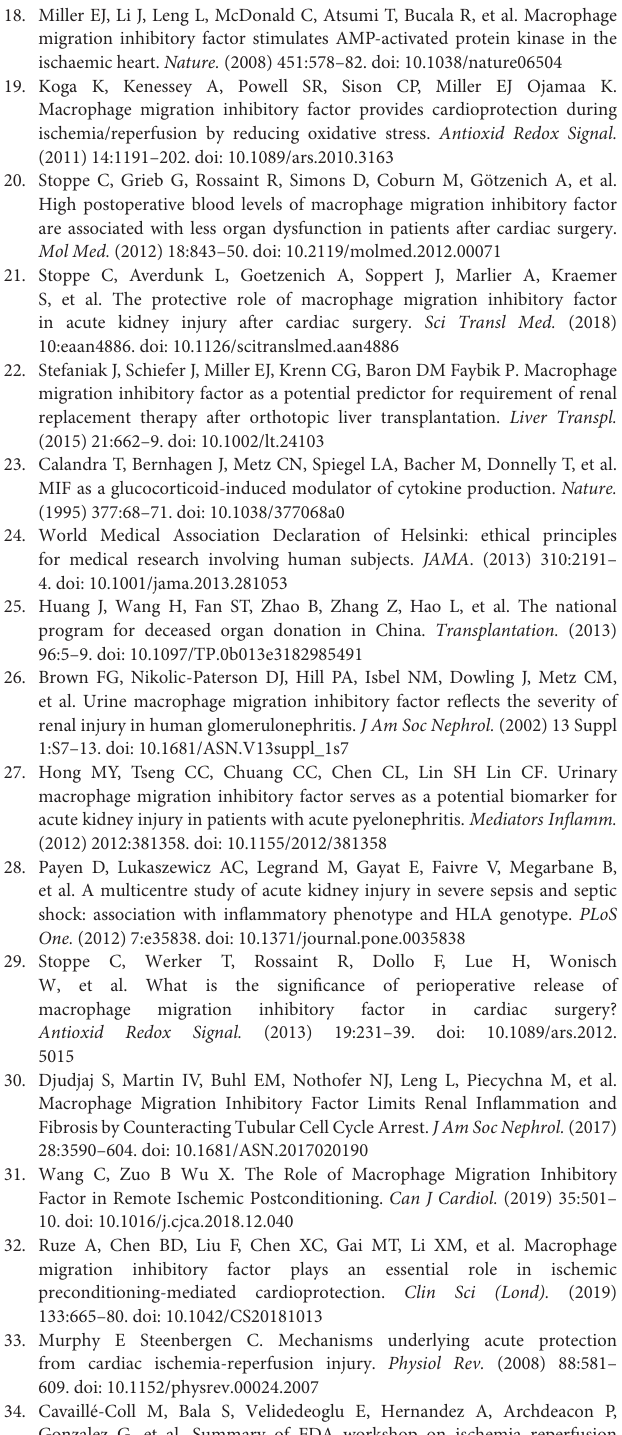
Supplementary Figure 2 | Variation of MIF from recipient during the perioperative period.